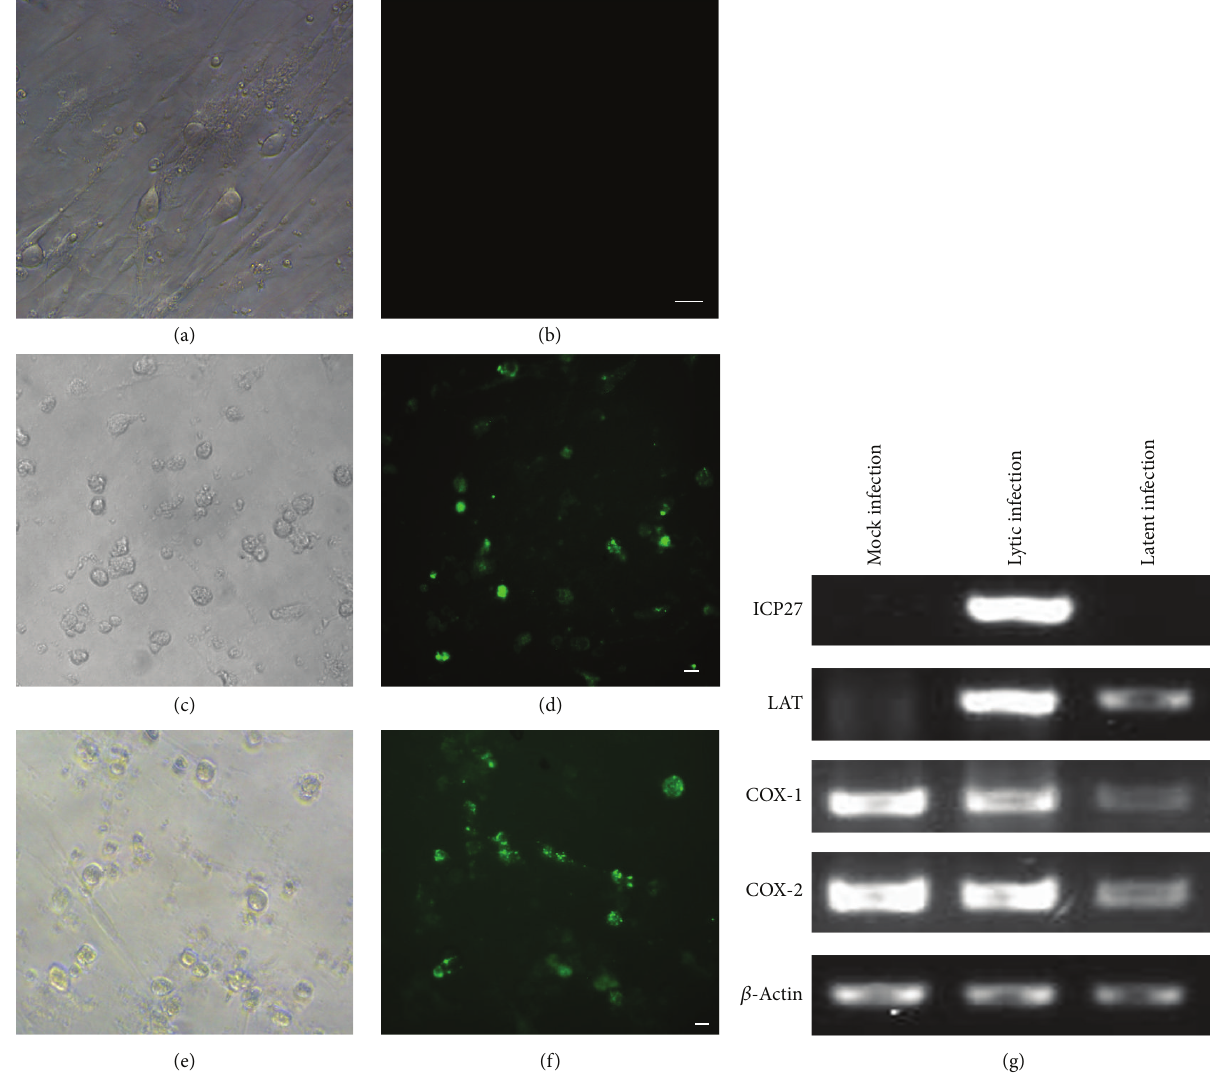
Figure 5: Latent HSV1 infection and reactivation in cultured VGNs. Light microscopy (a) and fluorescent microscopy (b) of latently infected VGN cultures. Light microscopy (c) and fluorescent microscopy (d) of latently infected VGN cultures treated with TSA. Light microscopy (e) and fluorescent microscopy (f) of latently infected VGN cultures treated with a combination of TSA and indomethacin. Detection of HSV-1 transcripts and COX-1/COX-2 mRNA by RT-PCR (g). Scale bar, 20